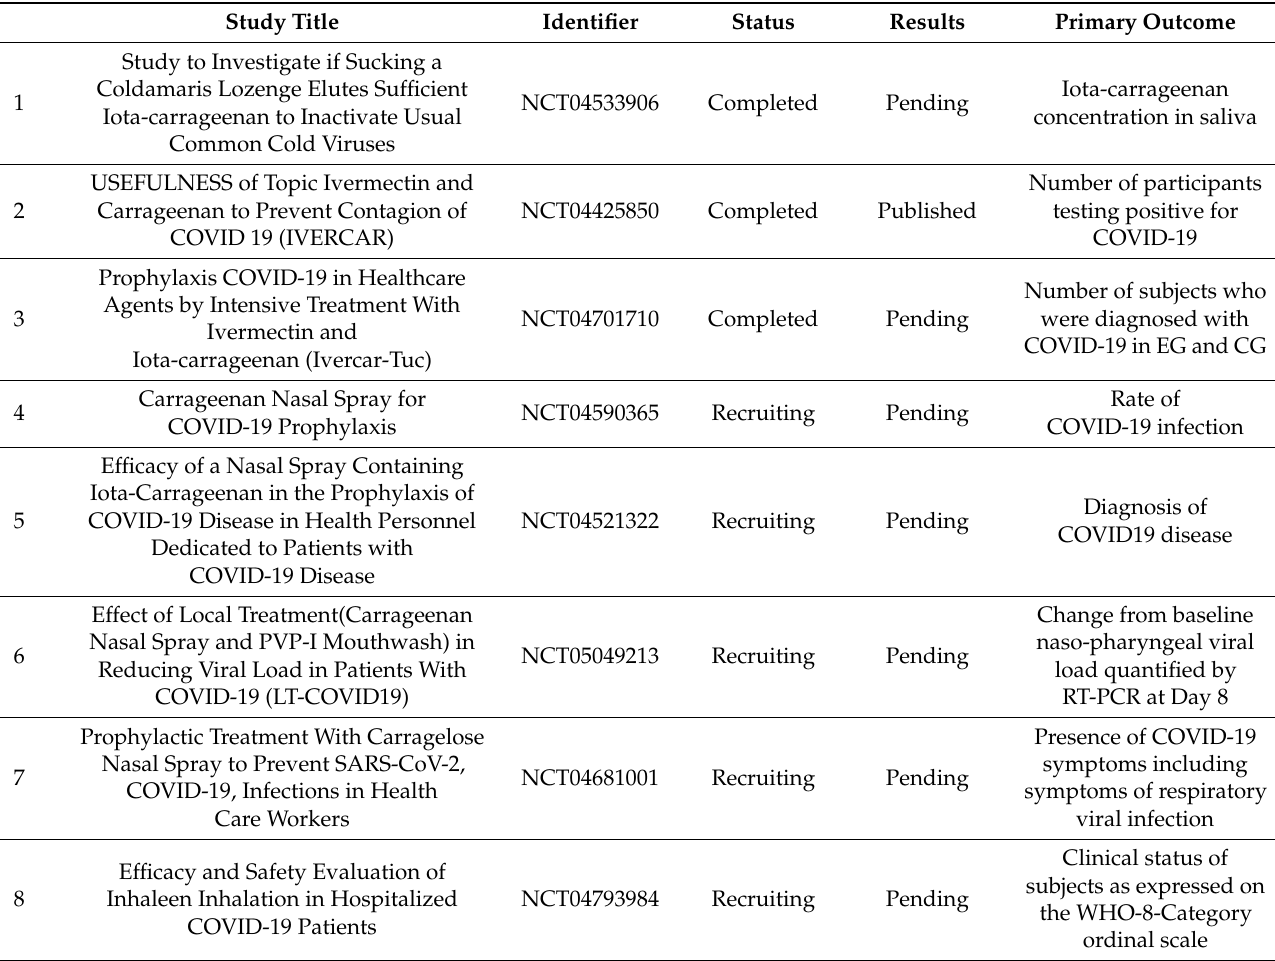
Table 3. Overview of all currently ongoing clinical trials of carrageenan against SARS-CoV-2 (listed at clinicaltrials.gov, accessed on 20 November 2021